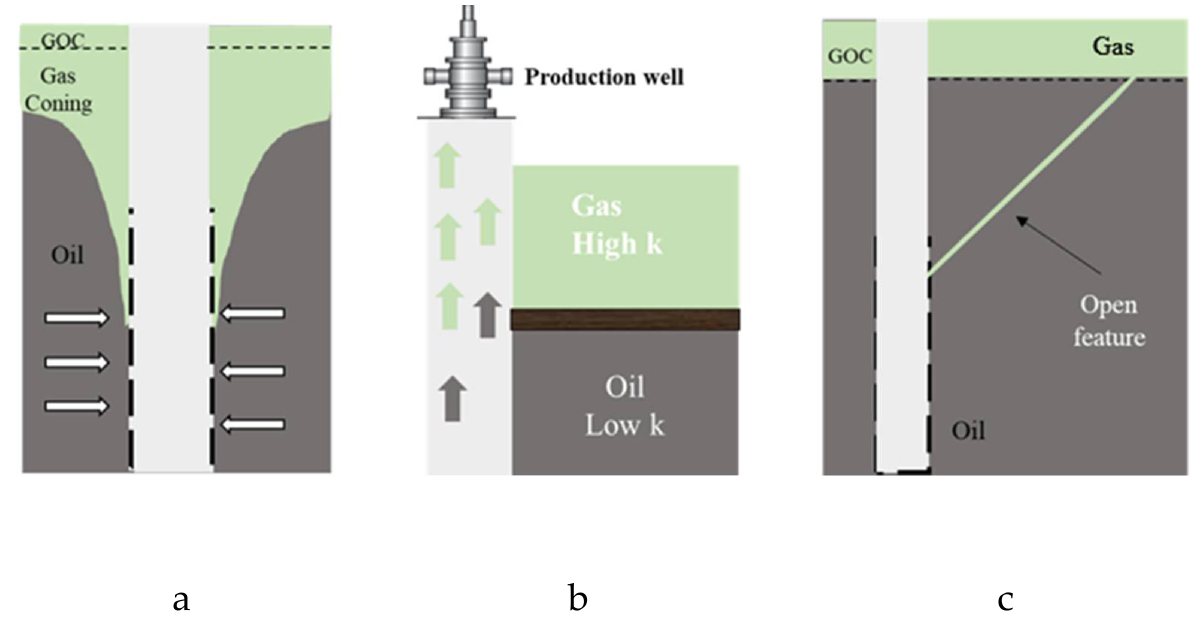
Figure 2. Sources of excess gas in oil production wells, ( a ) Gas coning, ( b ) High permeability contrast, ( c ) Open